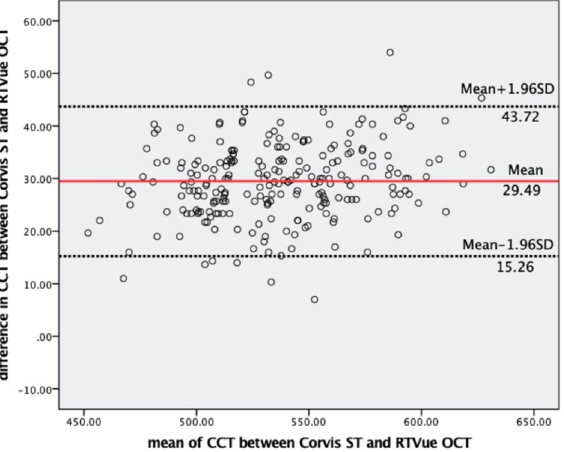
Figure 1. Bland–Altman plots show the agreement of CCT between the Corvis ST and RTVue OCT. The solid red line represents the mean difference, and the black dotted lines represent the 95% limits of agreement.